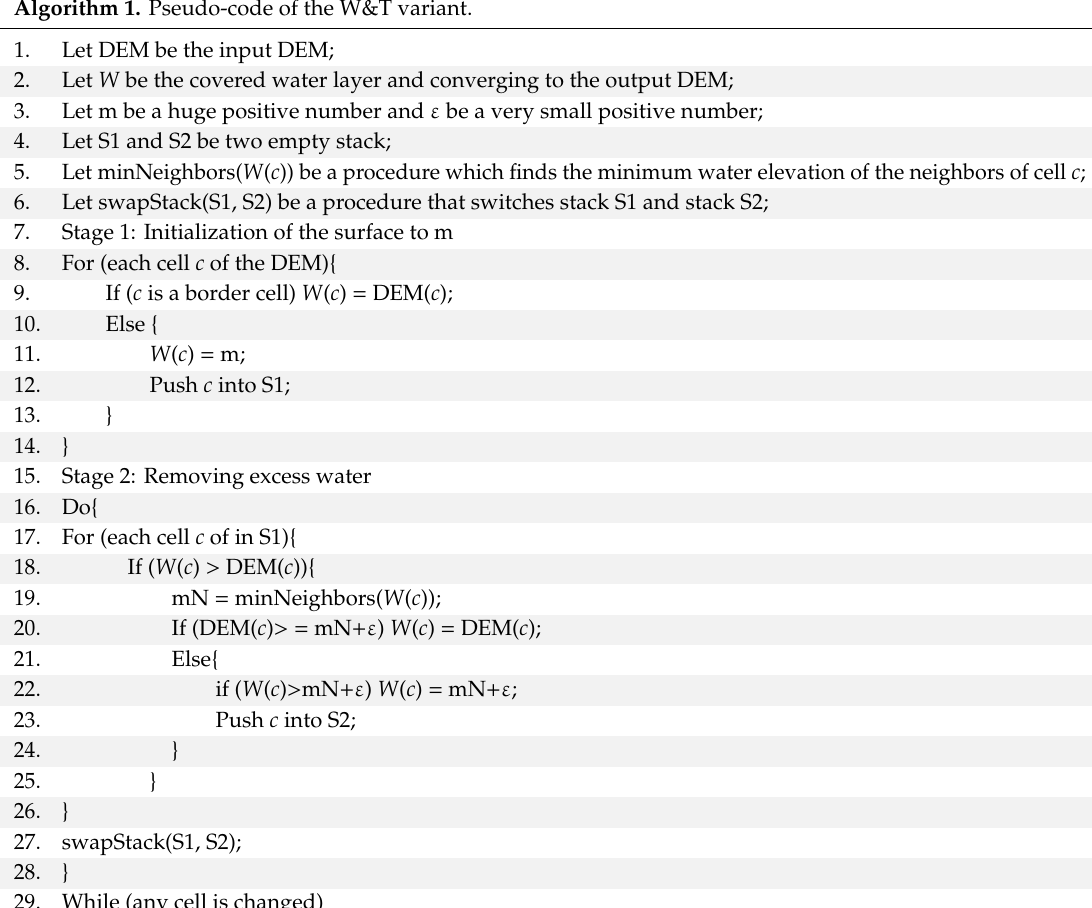
Algorithm 1. Pseudo-code of the W&T